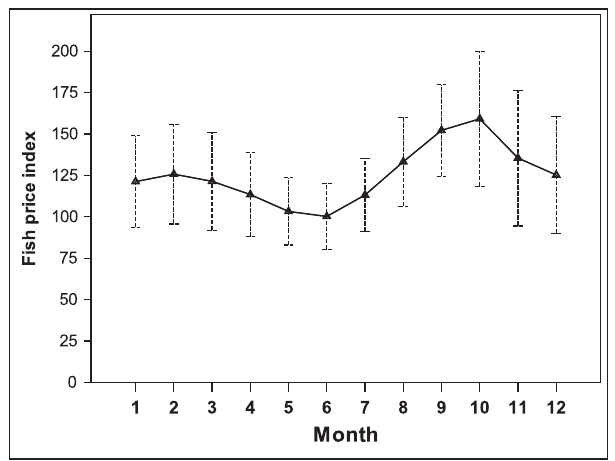
Fig. 4. Seasonal variability of the consumer price index (CPI) for fi sh in